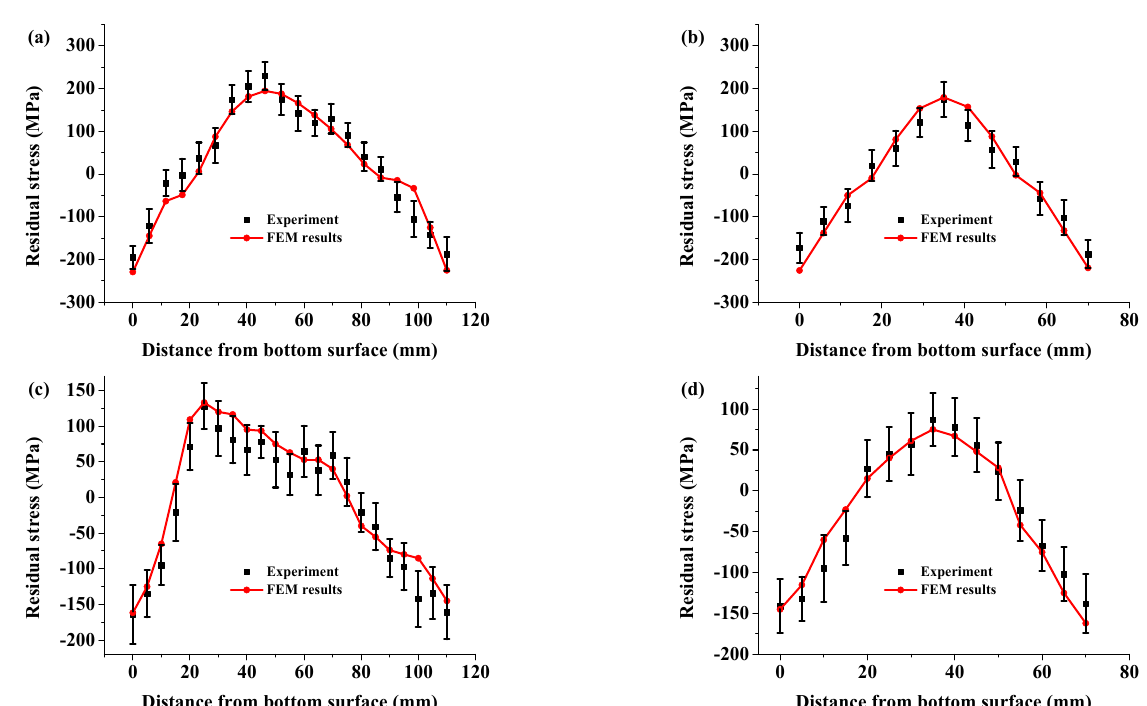
Table 3. Average surface residual stress after different processes.